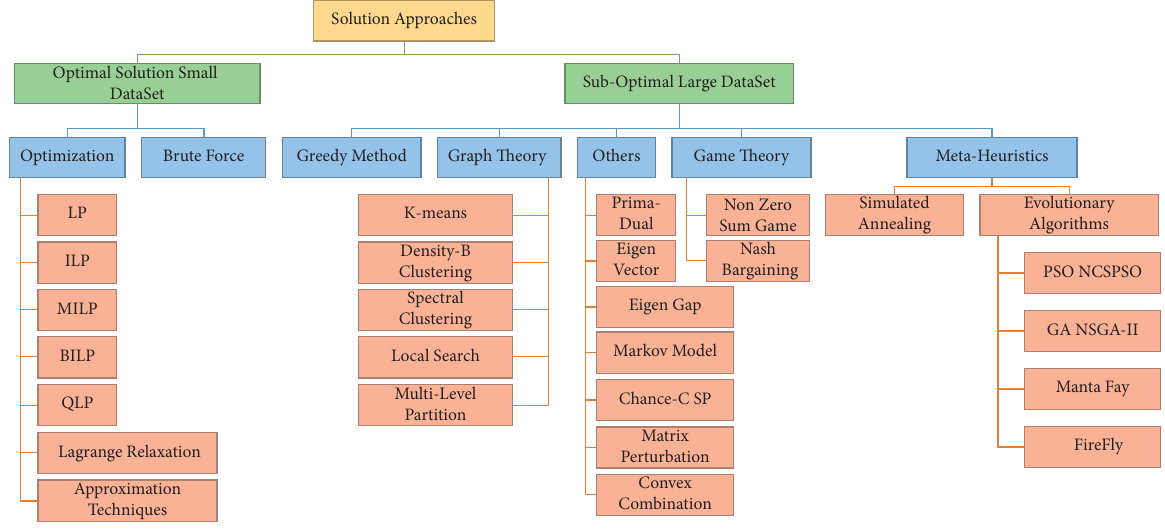
Figure 7: Taxonomy of CPP solution approaches.